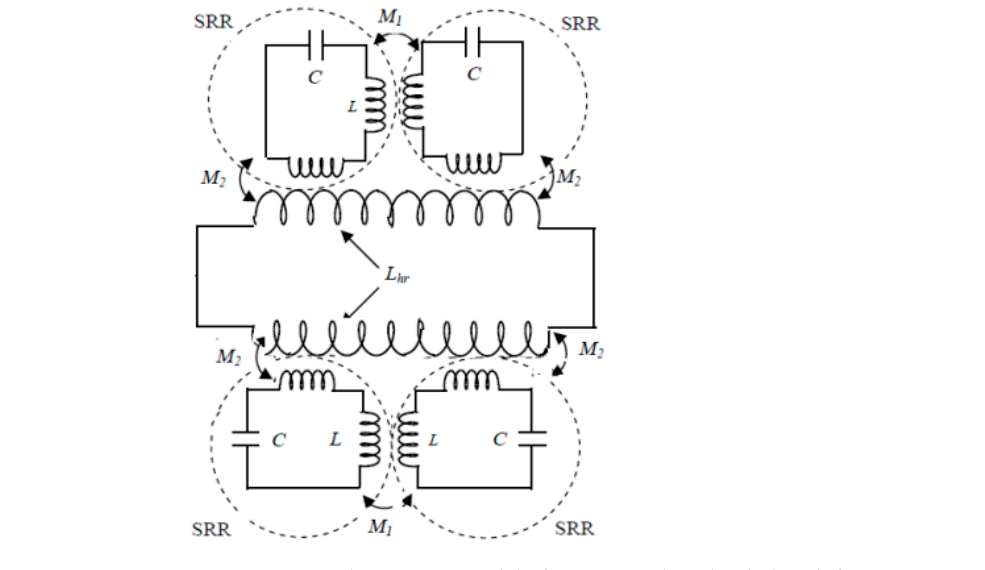
Figure 3. Equivalent circuit model of microstrip line, loaded with four SRRs.